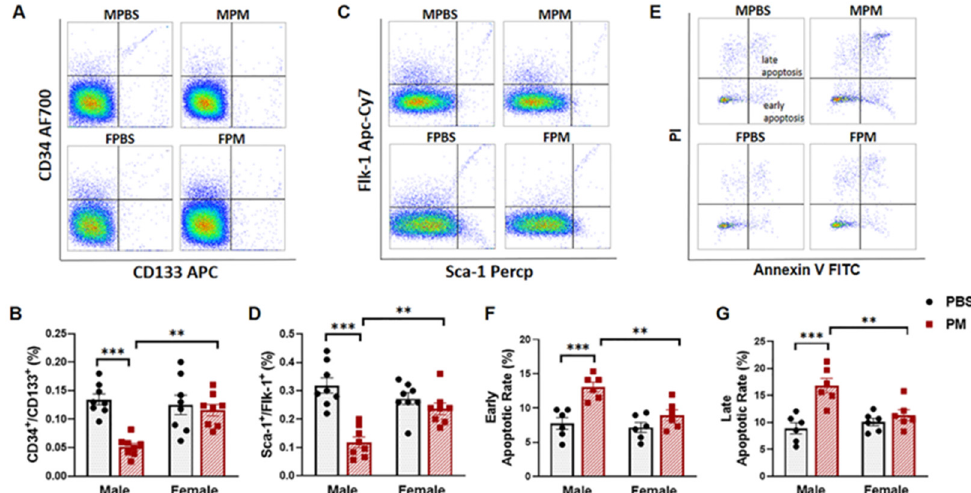
Figure 1. PM exposure selectively decreased circulating EPC levels with an increased apoptosis rate in male mice. ( A , C ) White blood cells were stained with CD133 APC and CD34 AF700 or Sca-1 Percp and Flk-1 Apc-cy7 antibodies for flow-cytometric analysis of circulating EPCs (CD34 + /CD133 + ) or (Sca-1 + /Flk-1 + ), with summary data ( B , D ) showing that decreased levels of circulating EPCs were only observed in WT male mice with PM exposure ( n = 8). ( E ) Annexin V and PI were used to incubate the blood cells for apoptosis analysis, which gated from EPCs (CD34 + /CD133 + ), with summary data showing that both early (Annexin V + /PI - ) ( F ) and late (Annexin V + /PI + ) ( G ) apoptotic rates of EPCs in male mice with PM exposure were significantly increased as compared to the PBS control group and female mice ( n = 6). MPBS: male mice with PBS treatment; MPM: male mice with PM exposure; FPBS: female mice with PBS treatment; FPM: female mice with PM exposure. ** p < 0.01 and *** p < 0.001.